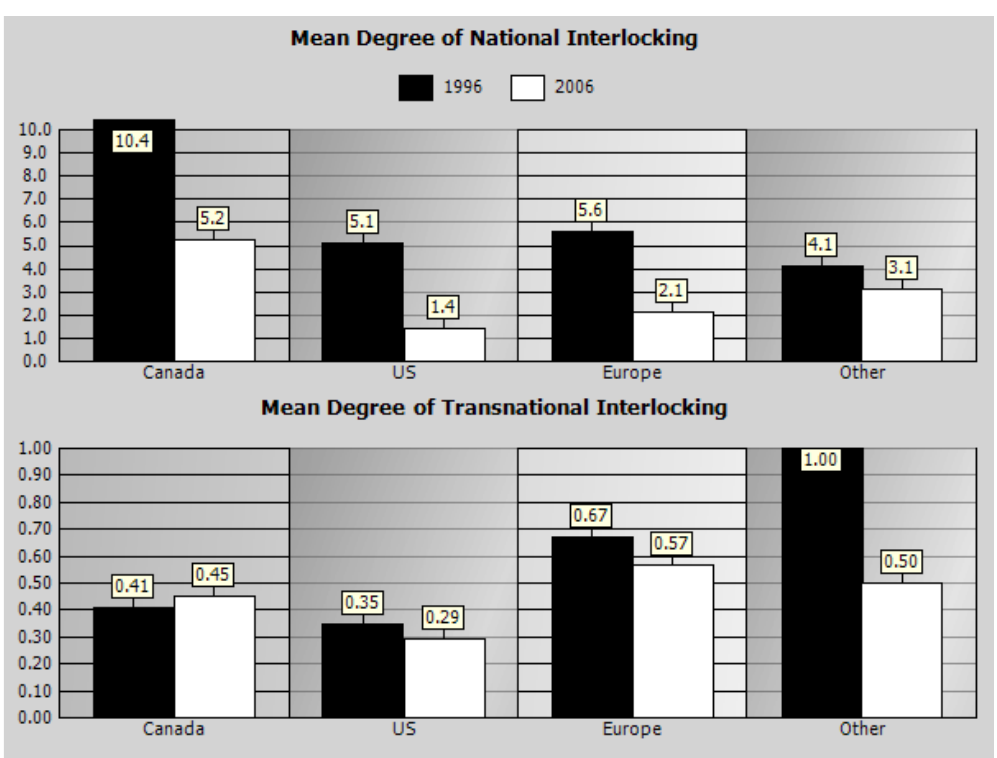
Figure 2. Mean Degree of National and Transnational Interlocking for Categories of Country of Control in the C250, 1996 and